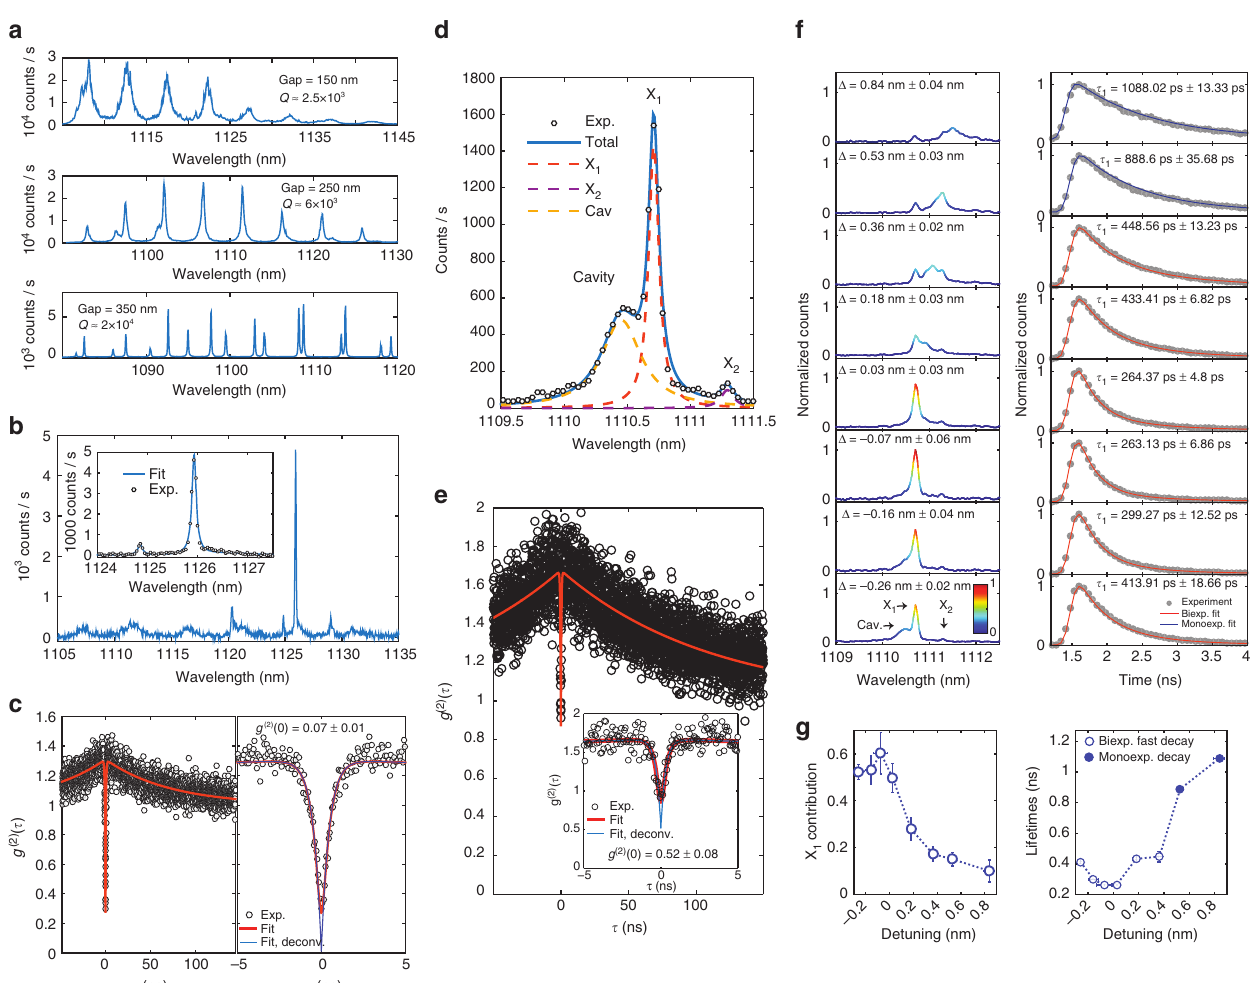
Fig. 6 Quantum dot-cavity coupling. a Photoluminescence (PL) spectra as a function of wavelength from a QD ensemble pumped with laser light at 975 nm, emitting inside three different GaAs microring resonators. Peaks are whispering gallery modes (WGMs) with quality factor Q , which increases with the microring-bus waveguide gap width. b PL spectrum for a single QD coupled to a Q ≈ 1.1 × 10 4 WGM. Inset: fi t of cavity-coupled QD emission near 1126 nm. c , Left: second-order correlation g (2) ( τ ) for the 1126 nm exciton line in b . Right: close-up near τ = 0. Circles are experimental data, red lines are a fi t. The blue curve and quoted g (2) (0) are obtained from the red fi t by deconvolving the detection time-response. d PL spectrum for a single QD in a microring, coupled to a Q ≈ 6 × 10 3 WGM. Circles: experimental data. Blue continuous line: fi t. Dashed lines: fi tting Lorentzians for the cavity and two excitons, X 1 and X 2 . e g (2) ( τ ) for X 1 in d . Inset: close-up near τ = 0. f , Left panel: PL spectra for varying spectral detuning Δ between X 1 and the cavity. Δ is obtained from fi ts as in d . All spectra are normalized to the intensity maximum at Δ ≈ − 0.07 nm. The color scale indicates normalized intensity. Right panel: corresponding X 1 photoluminescence decay curves. Gray dots are experimental data, red (blue) lines are biexponential (monoexponential) decay fi ts. For biexponential fi ts, τ 1 is the fast lifetime. g , Left panel: integrated intensity as a function of Δ for the fi ltered X 1 exciton contribution to the the PL spectra in f , obtained from Lorentzian fi ts as in d , normalized by the integrated intensity of the full fi tted spectrum. Right panel: decay lifetimes for the fi ts in f , as a function of Δ . Open blue circles are the fast biexponential decay lifetimes, closed blue circles are the monoexponential decay lifetimes. Uncertainties for g (2) (0), Δ and the X 1 magnitude are 95% fi t con fi dence intervals (two standard deviations). Lifetime uncertainties are single standard deviations from the exponential decay fi